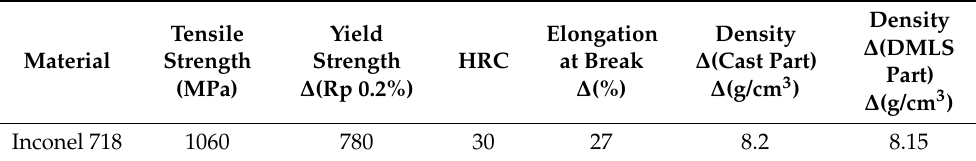
Table 1. Mechanical properties of the material Inconel 718 for DMLS and cast parts (at 20 ◦ C). Tensile Material